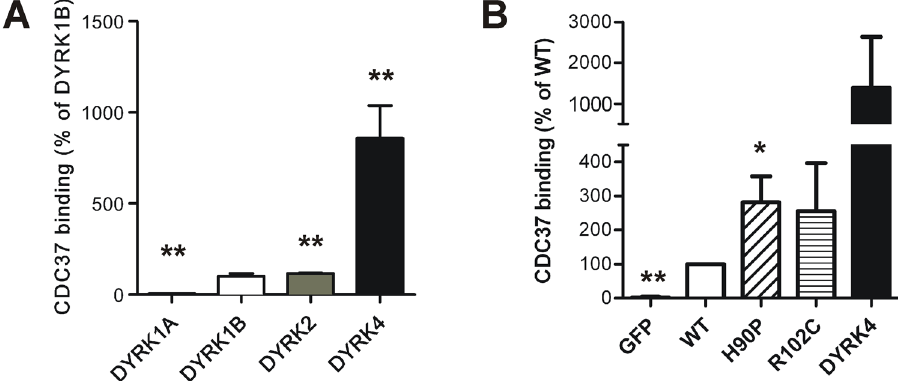
Figure 8. Interaction of DYRK family kinases and DYRK1B mutants with CDC37. ( A ) 293T cells stably expressing CDC37-nanoKAZ were transiently transfected with expression vectors for 3xFLAG-DYRK family kinases. Binding of CDC37-nanoKAZ to the kinases was determined from luminescence intensities relative to DYRK1B (means and SD, n = 8). ( B ) Wild type and mutant DYRK1B transfected in HeLa cells stably expressing CDC37-nanoKAZ. Association of CDC37-nanoKAZ with the immunoprecipitated GFP-DYRK1B constructs (WT, H90P, R102C) or GFP-DYRK4 is shown relative to wild type GFP-DYRK1B (means and SD, n = 4). Significant differences between wild type DYRK1B and other constructs are marked (two-tailed t-test, * p < 0.05, ** p <